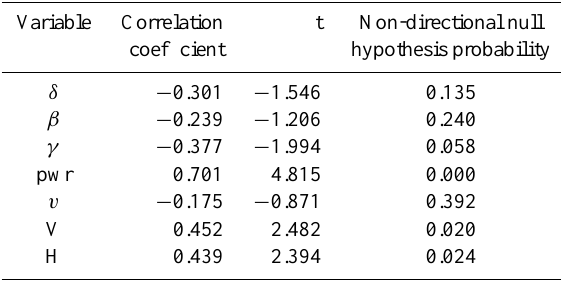
Table 4. Statistical correlations between φ and other observables, Student’s t-values and non-directional null hypothesis